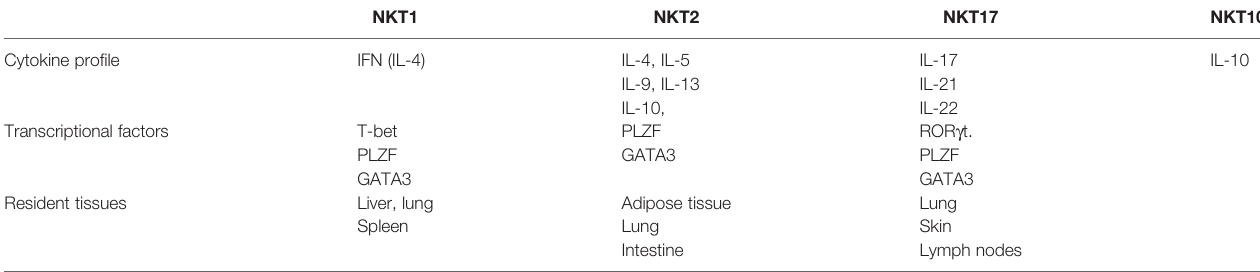
TABLE 1 | Subsets of NKT cells with different cytokine pro fi le and